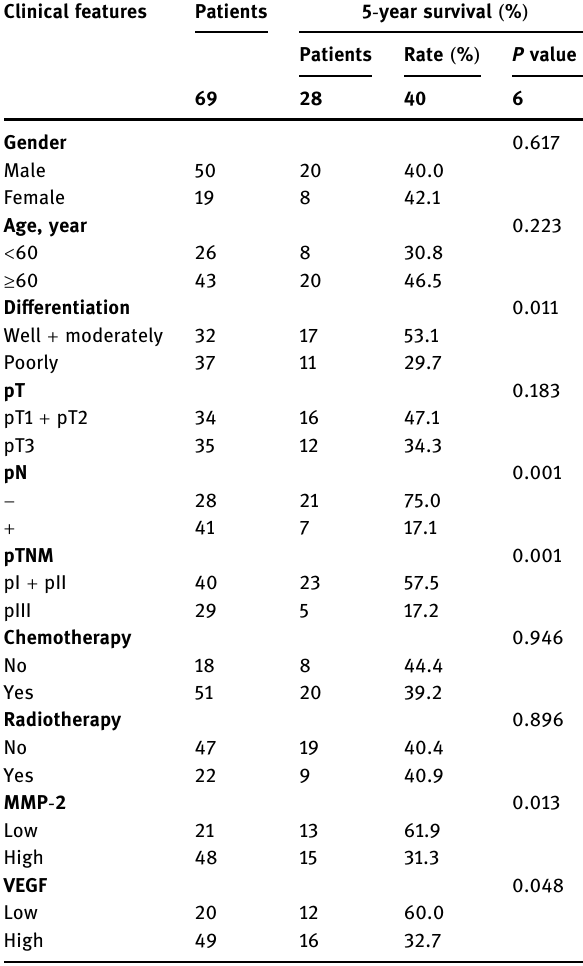
Table 2: Univariate analysis with respect to 5 - year survival of the patients with adenocarcinoma of the esophagogastric junction Clinical